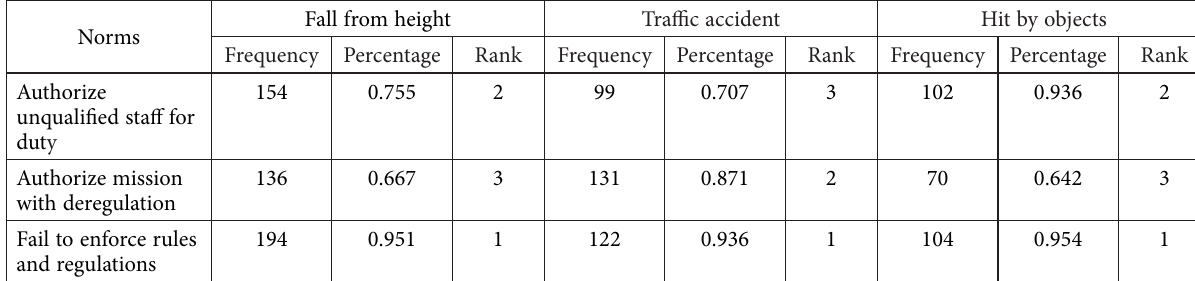
Table 9b. The norms of factor “supervisory violations” (main